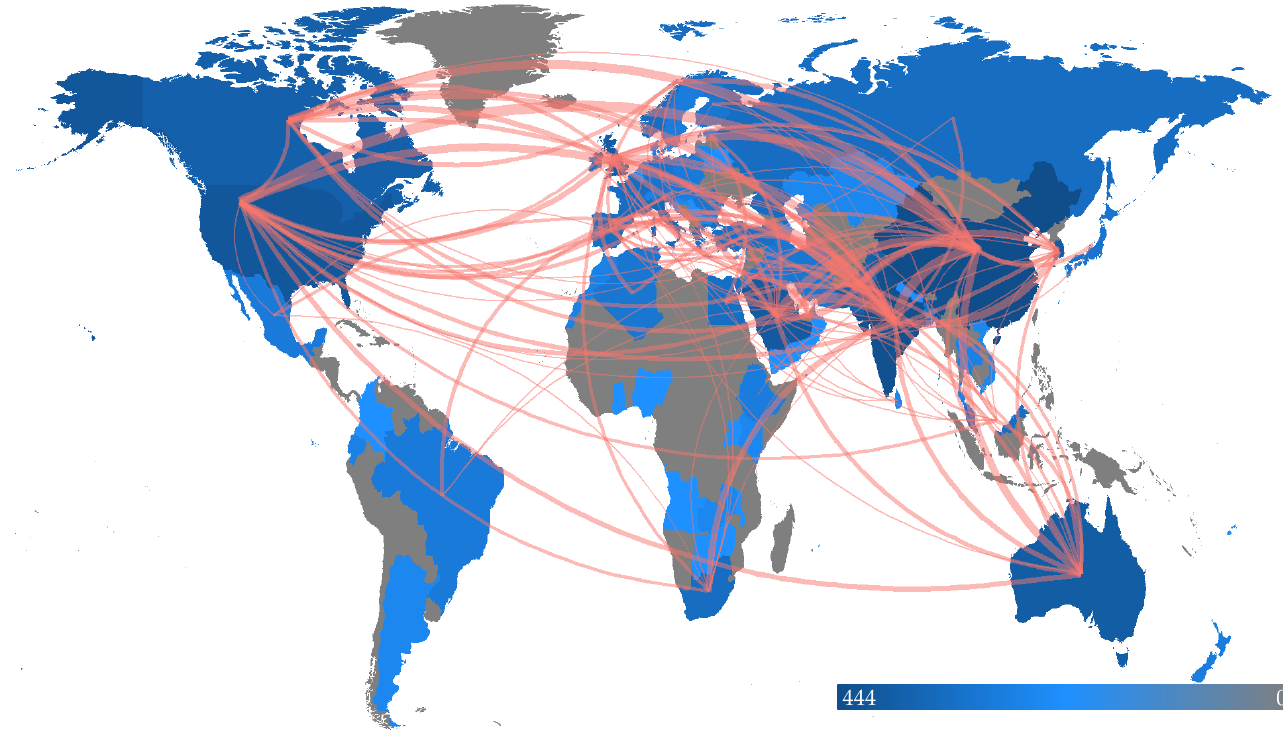
Figure 5. Scientific production in the subject area across the globe.